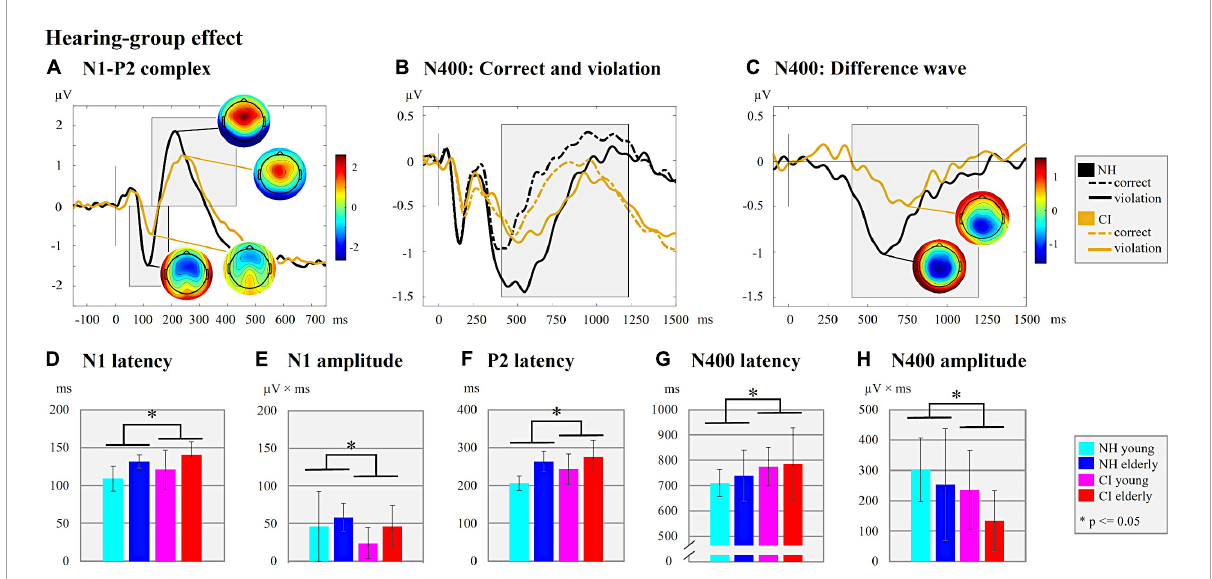
FIGURE3 Hearing-group effect. (A) N1-P2 complex. ERPs are shown for the two hearing groups (NH/CI) independent of the background noise (with/without) and the age (young/elderly). The ERP topographies at the N1 (CI user: 128 ms; NH listeners: 116 ms) and P2 peaks (CI user: 238 ms; NH listeners: 212 ms) are given separately for each hearing group. Gray-shaded boxes indicate the N1 and P2 time windows for peak and latency detection. (B) N400: Correct and violation. ERPs are shown for the two hearing groups (NH/CI) independent of the background noise and age but separately for the different semantic context of the sentences (semantically correct vs. semantically incorrect/violation). Gray-shaded box indicate the N400 time window for the peak and latency detection of the supplementary analyses. (C) N400: Difference wave. The difference waves of the N400 ERP are shown for each hearing group (NH/CI) independent on the background noise and age. The ERP topographies at the N400 peaks are shown for each hearing group (CI user: 750 ms; NH listeners: 600 ms). The Gray-shaded box indicates the N400 time window for the peak and latency detection. (D) N1 latency. Bar plots with mean N1 latency (ms) for each subgroup. (E) N1 amplitude. Bar plots with mean N1 amplitude ( µ V × ms) for each subgroup. (F) P2 latency. Bar plots with mean P2 latency (ms) for each subgroup. (G) N400 latency. Bar plots with mean N400 latency of the difference waves (ms) for each subgroup (H) N400 amplitude. Bar plots with mean N400 amplitude area of the difference waves ( µ V × ms) for each